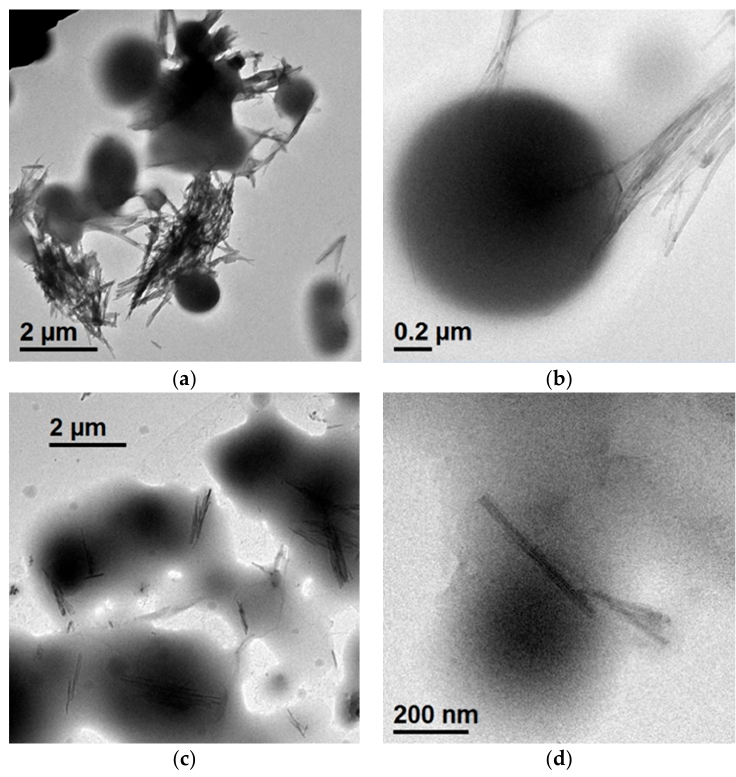
Figure 4. Transmission electron microscopy (TEM) images at different magnifications of dilute dispersions of SepX in NRL allowed to dry on a carbon-coated TEM grid: ( a , b ) SepS9/NR and ( c , d ) SepB5/NR colloidal systems.